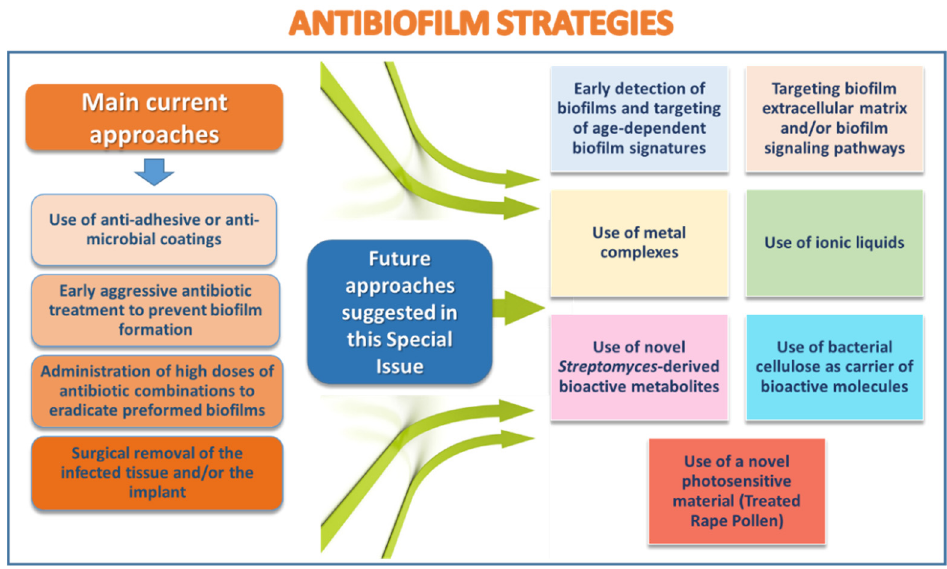
Figure 1. Current and developing anti-biofilm approaches .